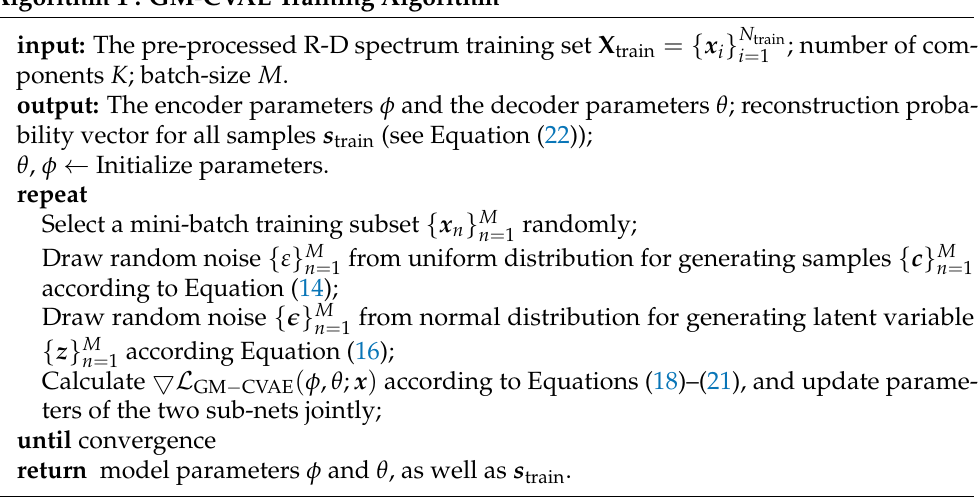
Algorithm 1 summarizes the GM-CVAE training algorithm under complex clutter